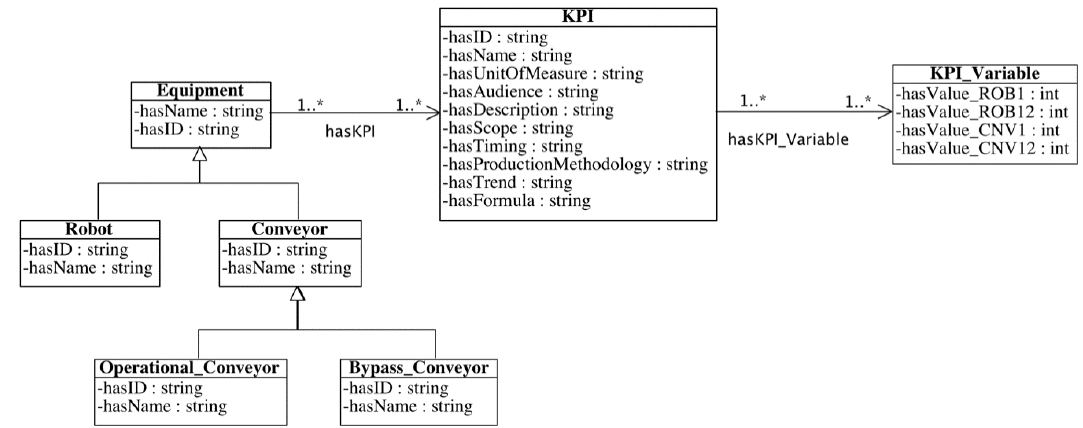
Figure 3. UML class diagram of the ontology, modified from [52].